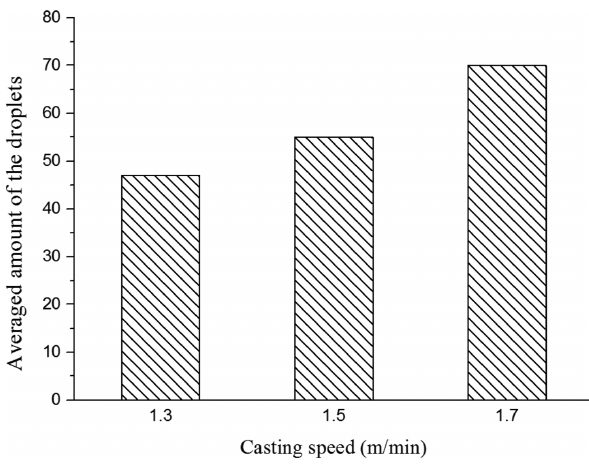
Figure 17: The total amount of the entrained droplets in the simu- lation during a 10 s period time at different casting